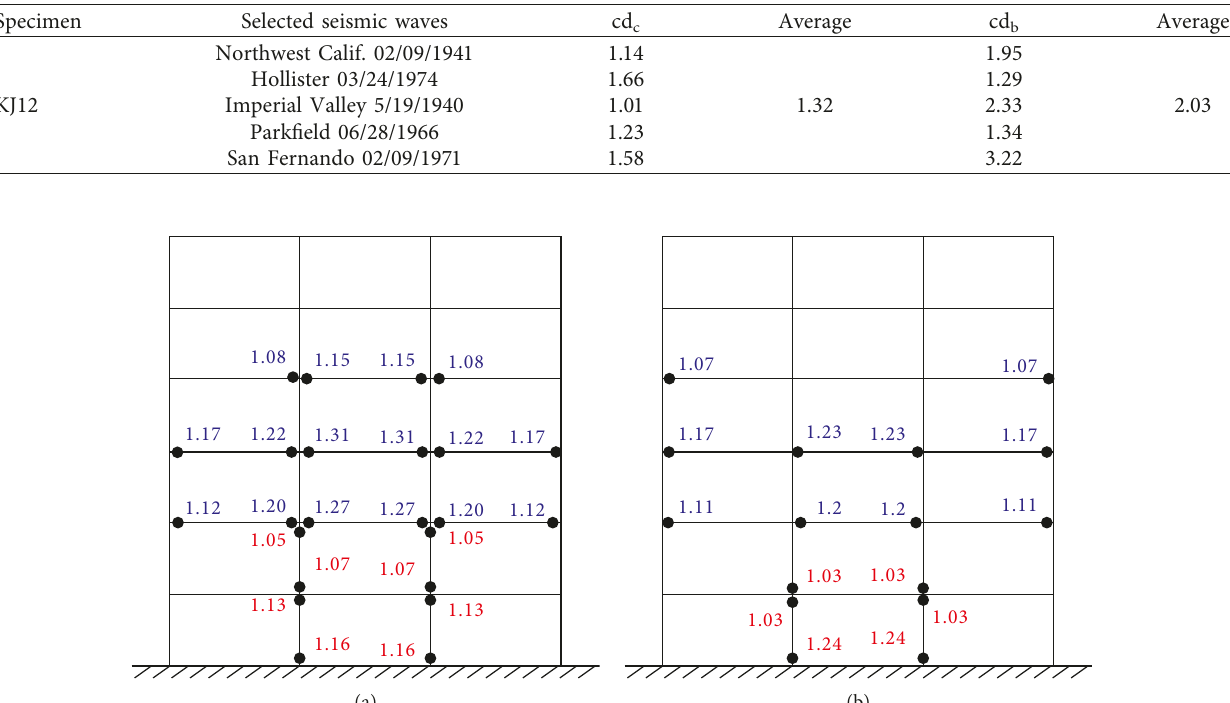
Table 30: Maximum curvature ductility coefficients of beams and columns in model KJ12.